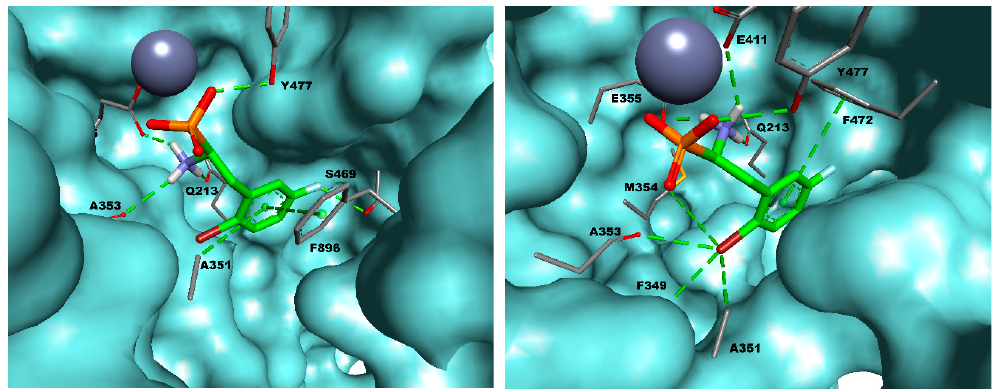
Figure 3. The mode of binding of compound 17b ( (S) isomer–left, (R) isomer–right) by hAPN (PDB: 4FYT). The coloring scheme is identical as in Figure 1. The bromine atom is shown as dark red stick.